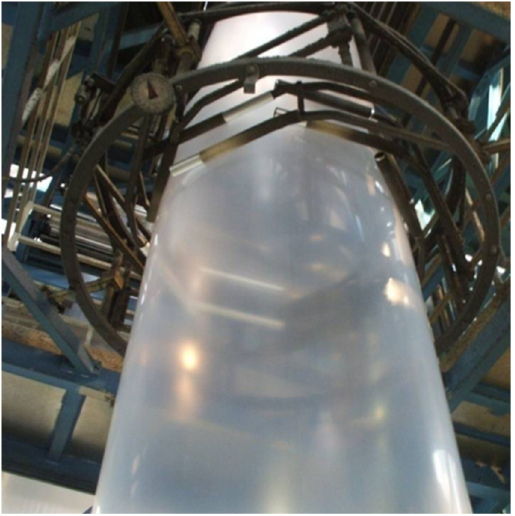
Figure 1. Photo of a bubble for plastic film extrusion. Bubble diameter is 1.5 m.